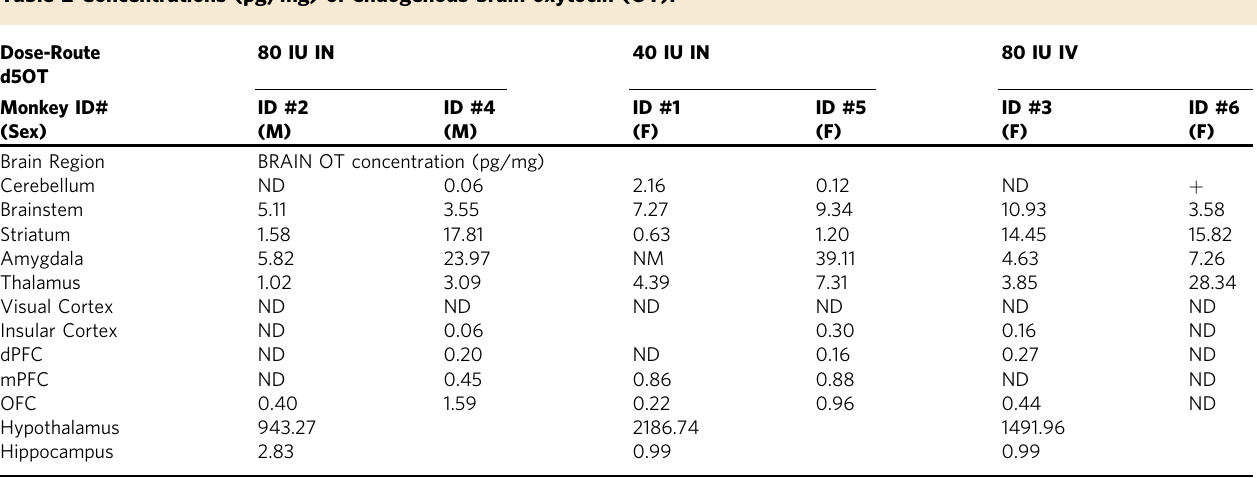
Table 2 Concentrations (pg/mg) of endogenous brain oxytocin (OT). Dose-Route